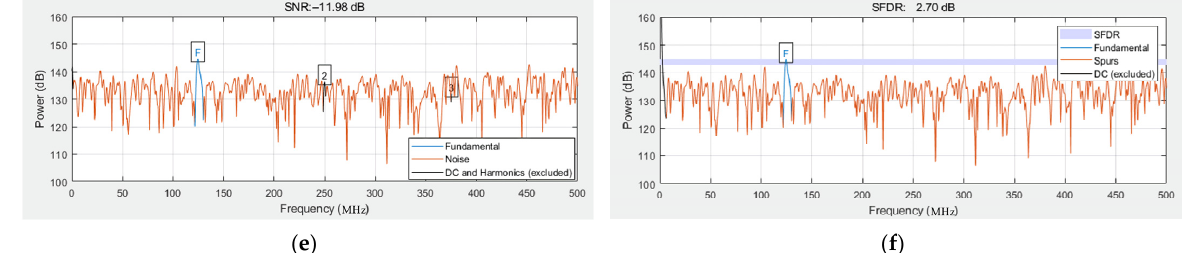
Figure 10. Extracted SNR and SFDR parameters: ( a ) extracted SNR when the frequency of the input signal is 4780 MHz; ( b ) extracted SNR when the frequency of the input signal is 4780 MHz; ( c ) ex- tracted SNR when the frequency of the input signal is 4820 MHz; ( d ) extracted SNR when the fre-